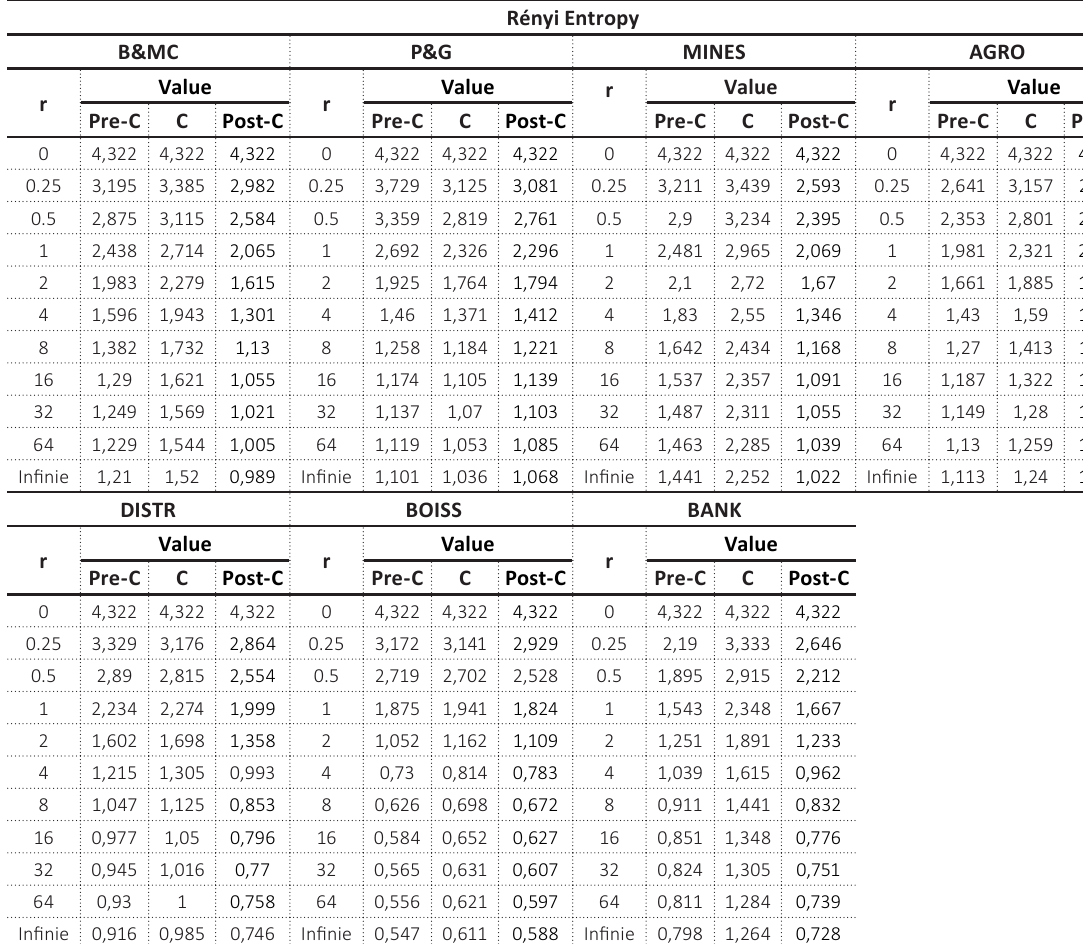
Table A1. Different Rényi entropy measures of B&MC, P&G, MINES, AGRO, DISTR, BOISS, and BANK before the COVID-19 crisis (Pre-c), during the COVID-19 crisis (C), and after the COVID-19 crisis (Post-C) Rényi Entropy